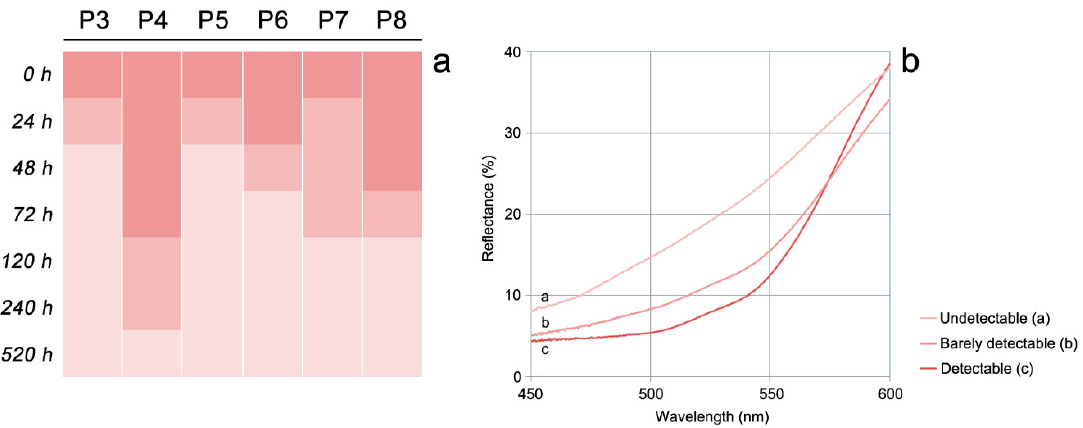
Figure 5. ( a ) Overview of the results obtained by FORS for mock-ups exposed to artificial solar radiation. The darkest colour indicates that madder signals are clearly detectable while the lightest colour indicates that madder signals are undetectable. The colour between these two situations indicates that the madder signals are barely detectable in the FORS spectra. ( b ) Examples of spectra for these three situations—focused on the most selective spectral range for the detection of ML—are reported in the right part of the picture.